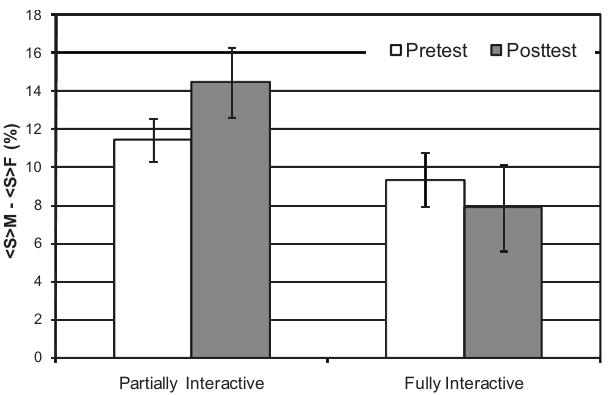
FIG. 1. Pretest and post-test gender gaps (cid:1)(cid:5) S (cid:6) M − (cid:5) S (cid:6) F (cid:2) for par- tially and fully interactive courses. Student performance on the FMCE is averaged over three semesters (cid:1) partially interactive (cid:2) and four semesters (cid:1) fully interactive (cid:2) . Error bars represent the standard errors of the mean. There is no statistically significant shift in the gender gap for either partially or fully interactive